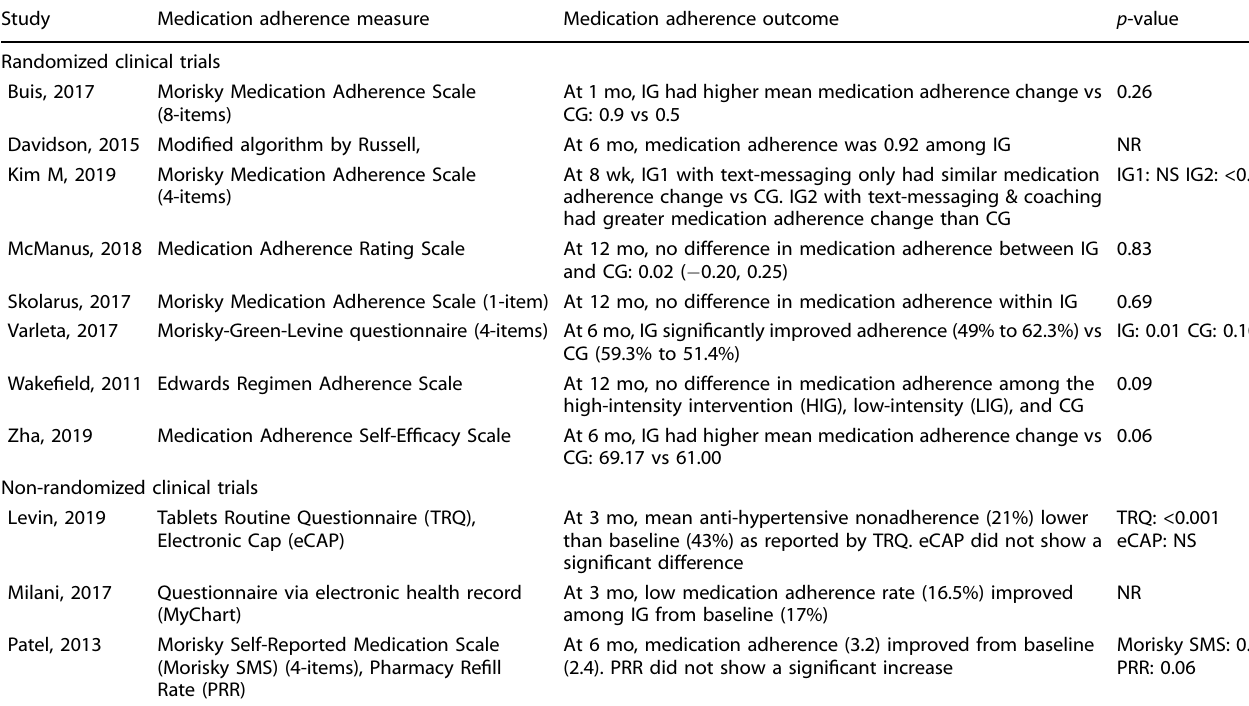
Table 4. Medication adherence